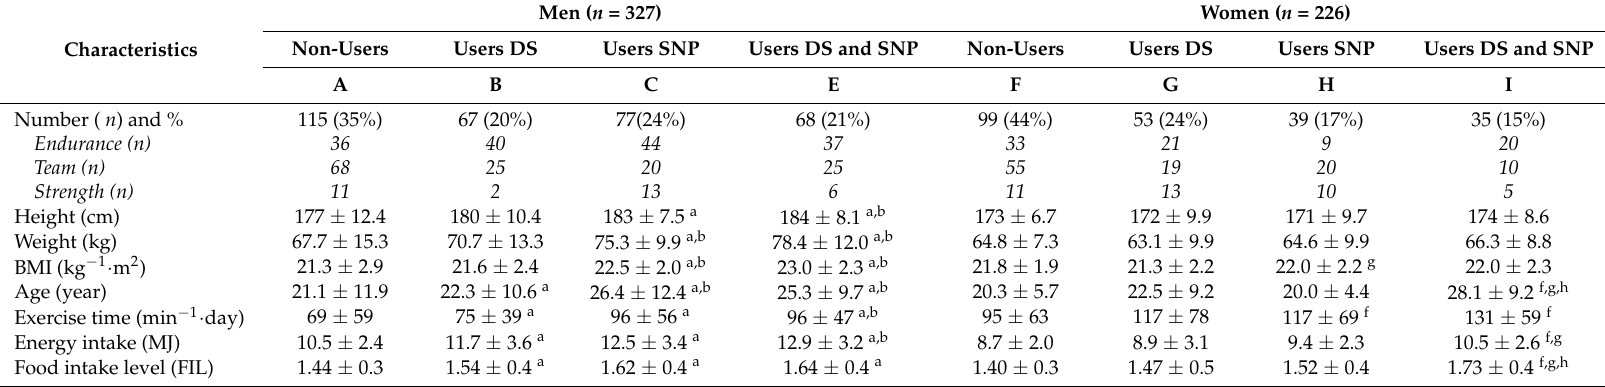
Table 1. Mean ± SD of characteristics, duration of exercise and energy intake per day, and food intake level (FIL) for the total group and subgroups of athletes.